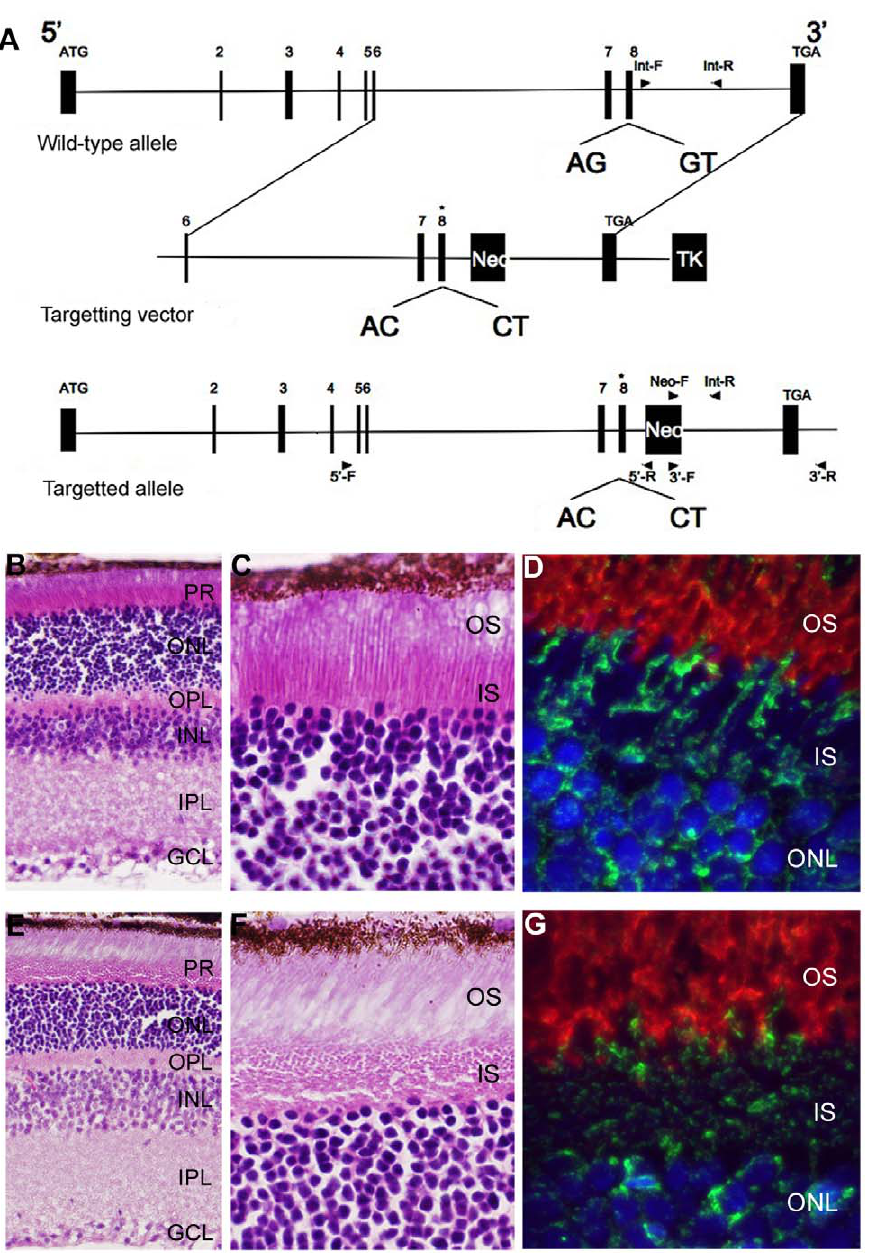
Figure 6. Generation and initial characterization of a Bbs3L mutant mice. (A) Schematic for the targeted alteration of the splice donor and acceptor sites of exon 8 (asterisk) found in the Bbs3L transcript. Homologous recombination leads to the inclusion of these altered sites and the loss of Bbs3L. Hematoxylin/eosin staining of cryosections from 8-month old Bbs3L + / + (B,C) and Bbs3L 2 / 2 (E,F) mouse retinas. Disruption of the normal photoreceptor architecture was observed in Bbs3L 2 / 2 mice. Immunohistochemistry analysis of cryosections from (D) wild-type and (G) targeted mutants retinas using the Bbs3 antibody (green) and rhodopsin (red), a marker for rod photoreceptor outer segments. To-Pro3 was used as a counterstain for nuclei. PR, photoreceptor; ONL, outer nuclear layer; OPL, outer plexiform layer; INL, inner nuclear layer; IPL, inner plexiform layer; GCL, ganglion cell layer.